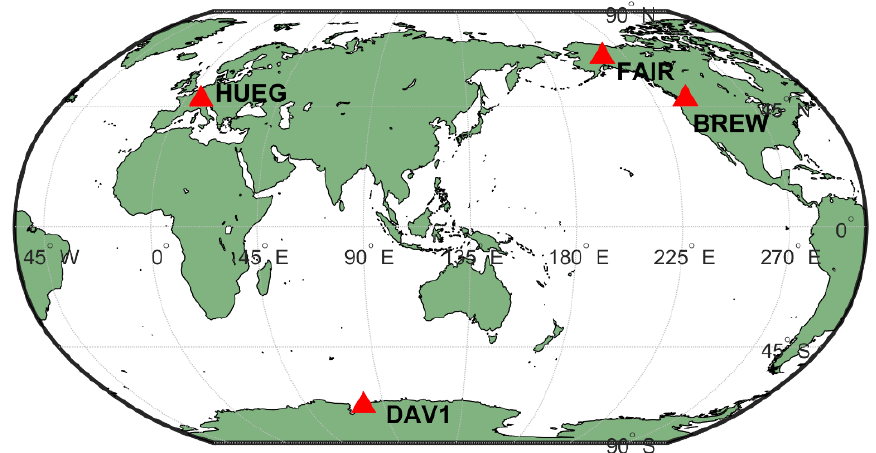
Figure 2. The distribution of the four IGS stations used for experimental PPP test. Table 2. Detailed processing strategies for the experimental static PPP.